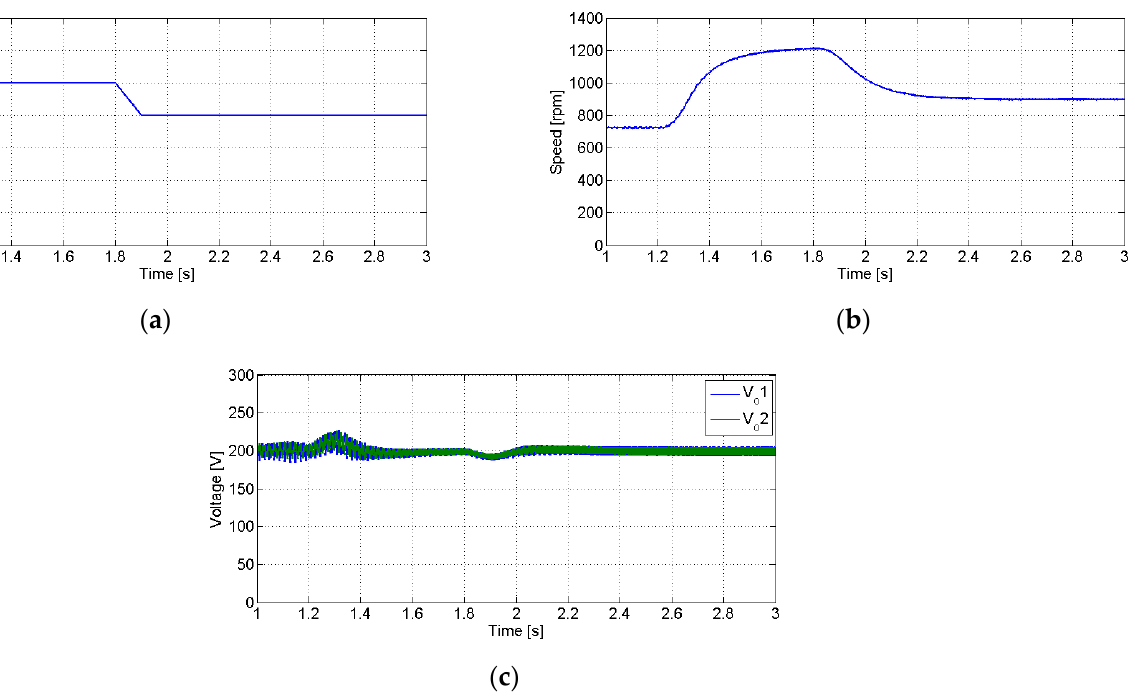
Figure 9. Obtained simulation waveforms during the connection of the system: ( a ) solar irradiation applied to the PV panels, ( b ) SRM motor speed, ( c ) DC/DC output voltages.